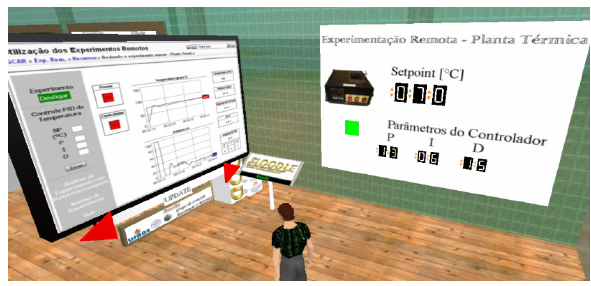
Figure 3. Immersive experiment